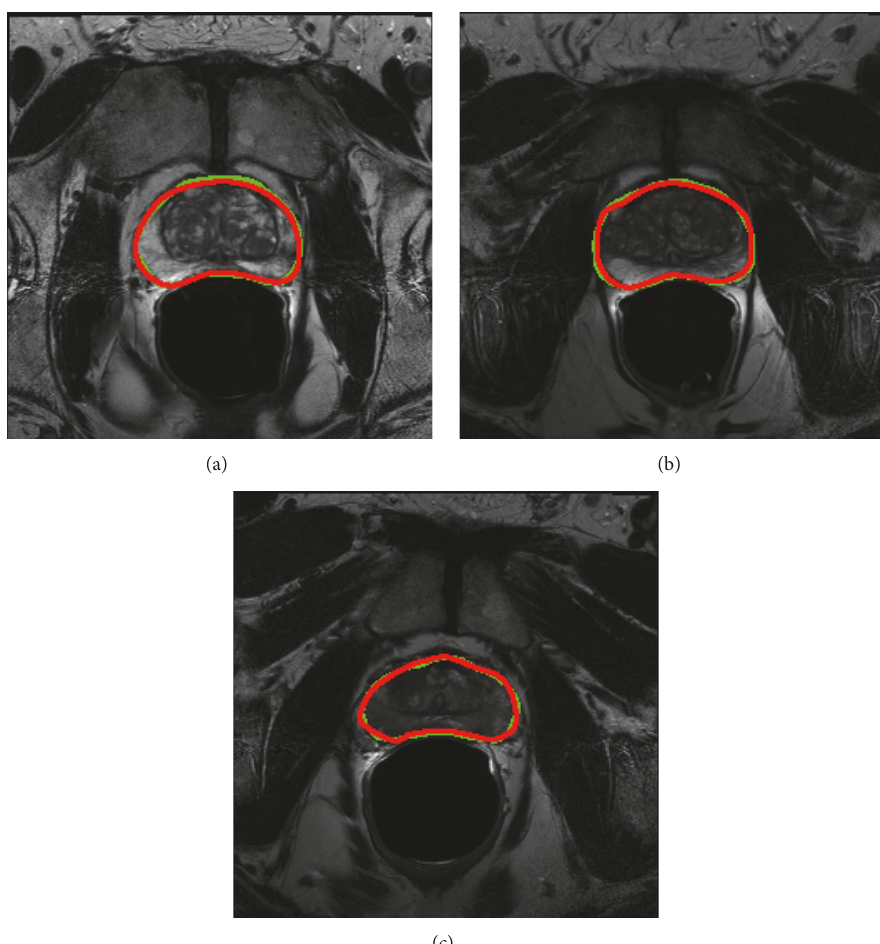
Figure 13: Parts of MRI prostate images segmentation results. The red and green contour denote ground truth and the result of UR-Net.